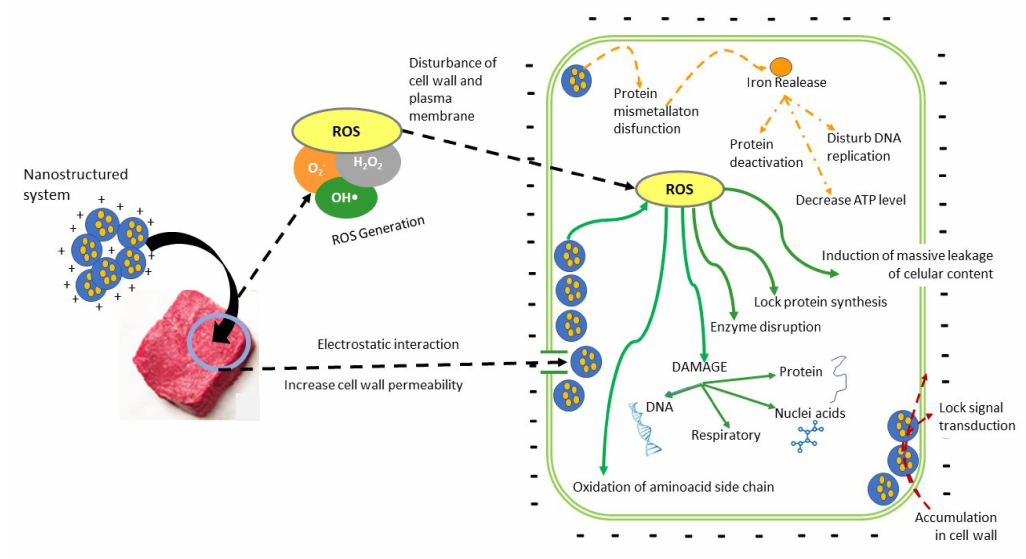
Figure 3. Action mechanism of nanostructured systems as antimicrobial agents applied to